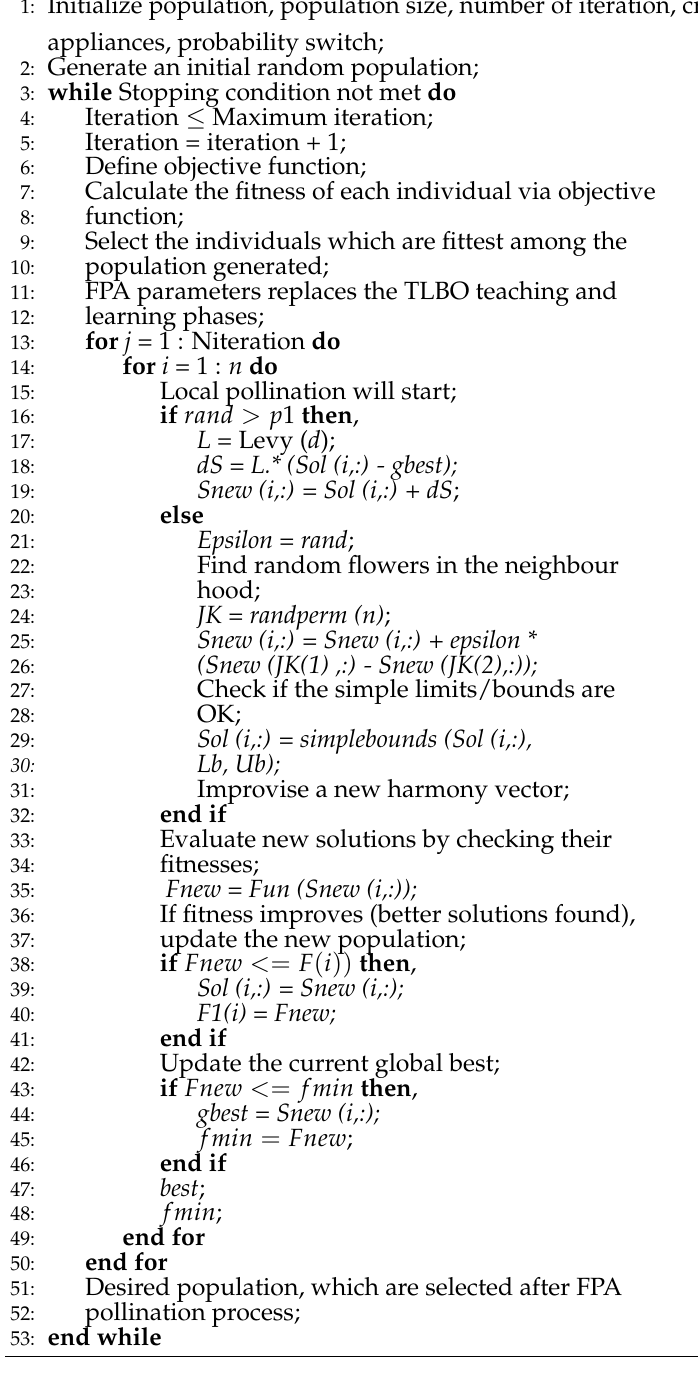
Table 3. Comparison of heuristic techniques